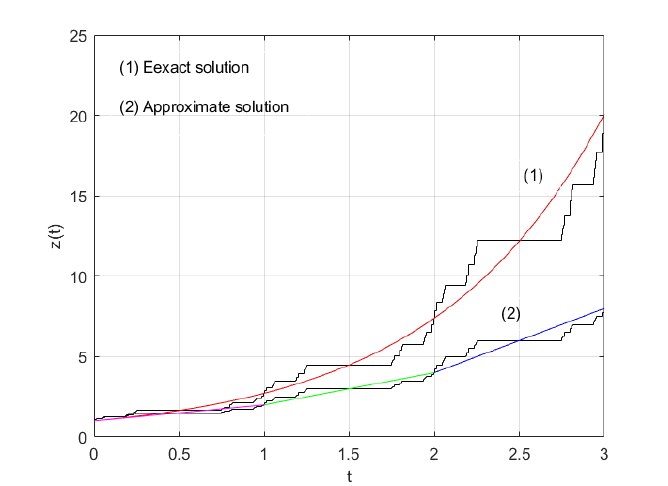
Figure 2. Exact solution and approximate solution using numerical fractal Euler method where step sizes h = 1 and α =